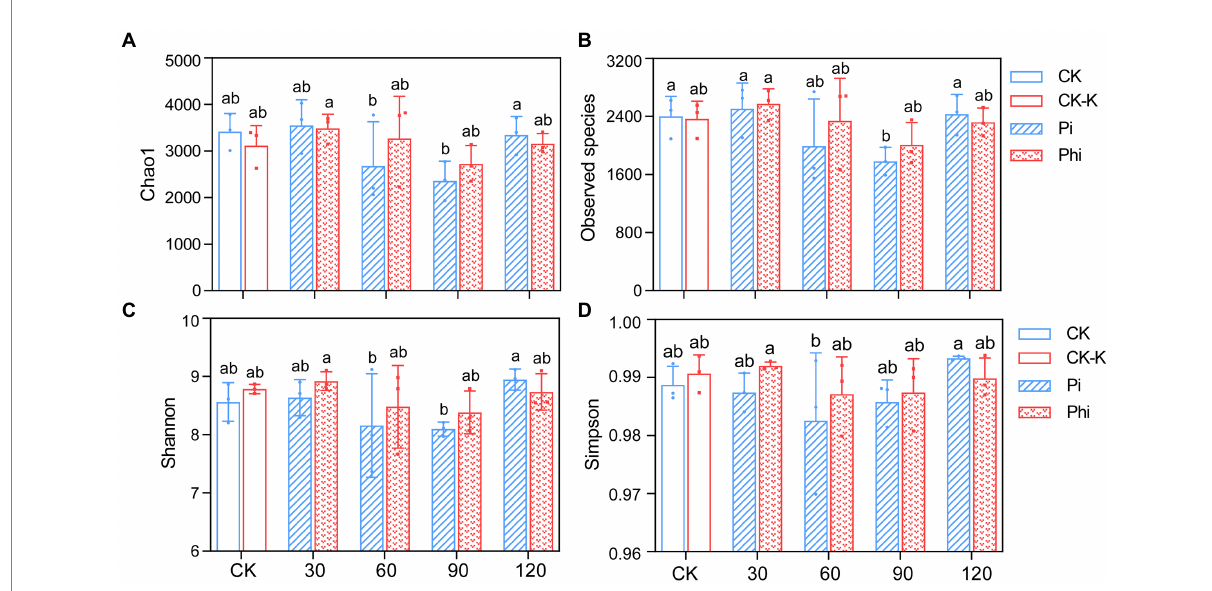
FIGURE 3 The α -diversity of the phoD -harboring bacterial community. (A) Chao1 index. (B) Observed species index. (C) Shannon index. (D) Simpson index. The treatment levels are represented as the average value ± standard error ( n = 3), and the different letters indicate the significant differences ( p < 0.05). CK denotes non-fertilized control; CK-K, potassium-fertilized control; Phi represents phosphite fertilizer; Pi, phosphate fertilizer. The values 30, 60, 90, and 120 in X -axis indicate 30, 60, 90, and 120 mg P 2 O 5 kg − 1 soil,